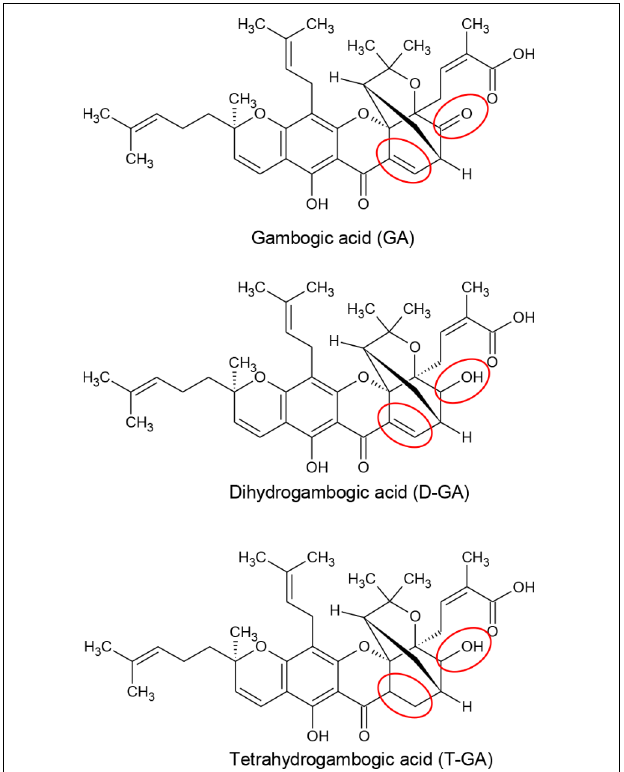
FIGURE 1 | Chemical structures of GA, D-GA, and T-GA. The red circles indicate the structural differences in the three compounds.